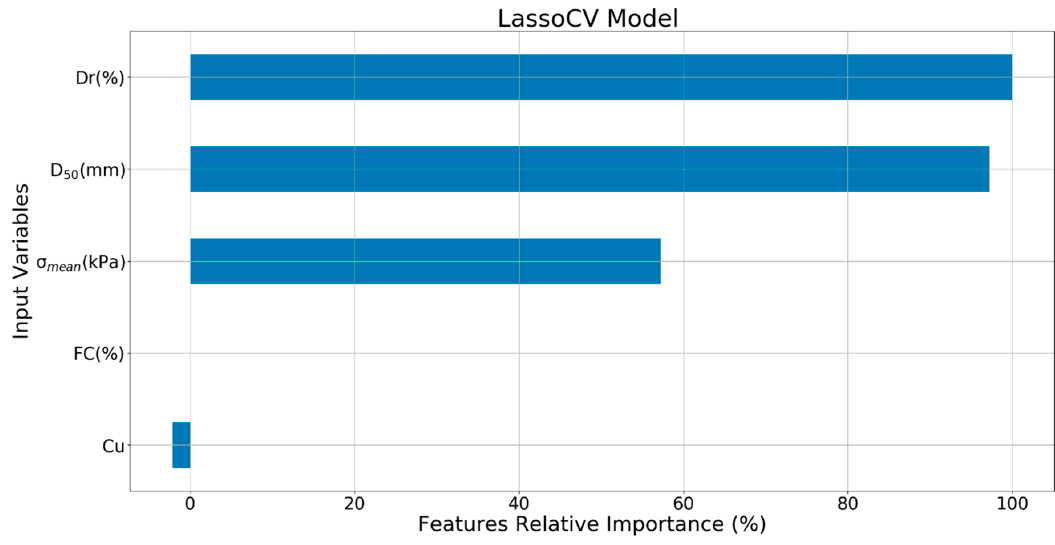
Figure 16. Relative importance of the input variables for the developed LassoCV model.